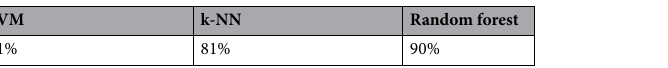
Table 3. The accuracy rate of prediction for the VR suitability in the long-term serve–return training in each algorithm.